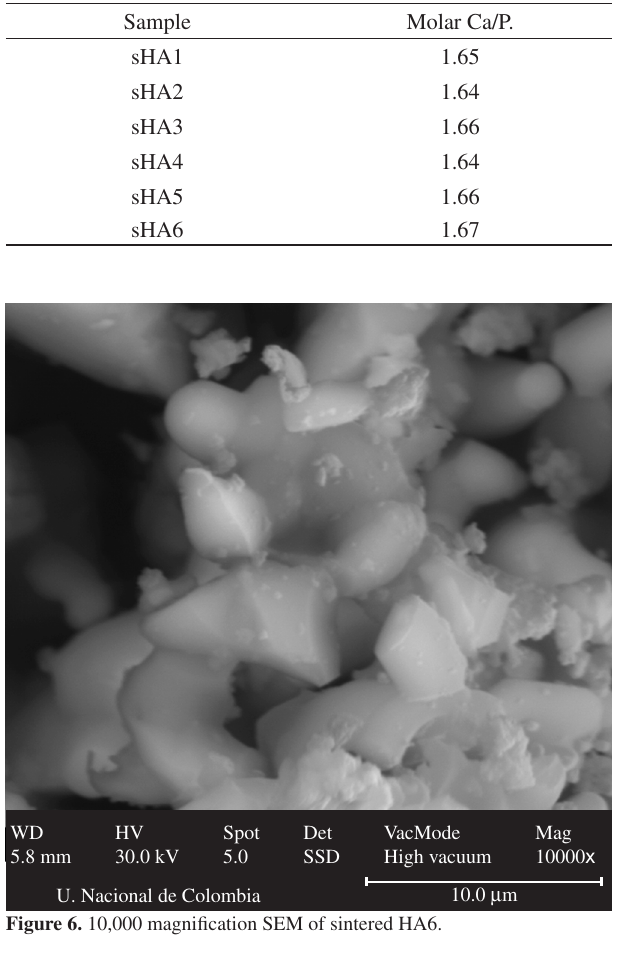
Figure 6. 10,000 magnification SEM of sintered HA6.